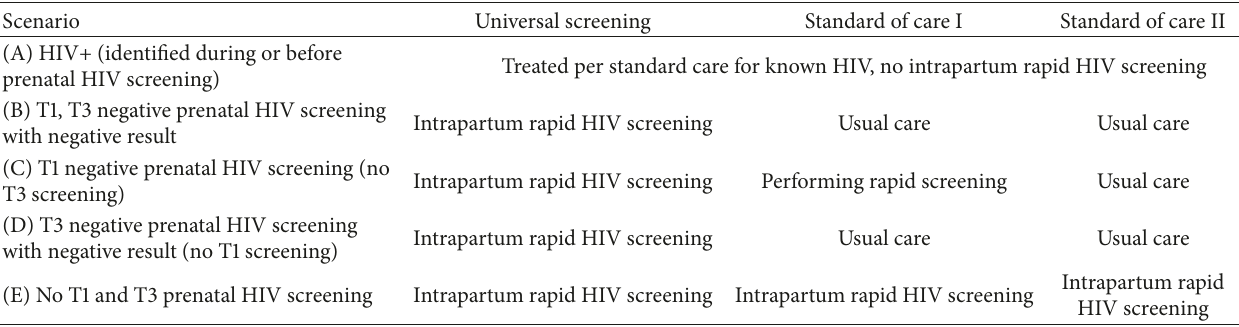
Table 1: Explanation of three strategies of care at delivery based on scenarios at prenatal